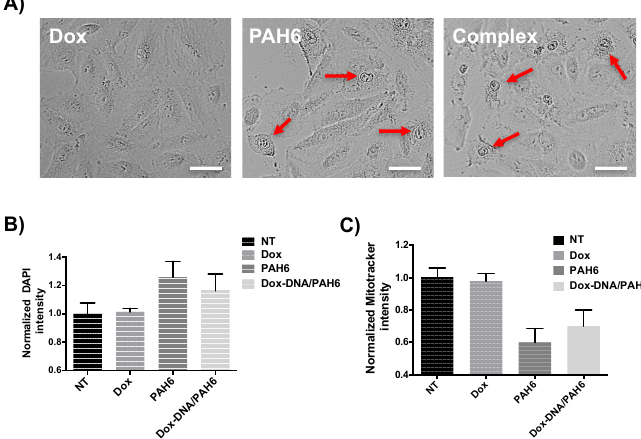
Figure 3. ( A ) Optical micrographs showing the morphologies of the A549 cells after 30 min incubation with Dox (2 µ g/mL), PAH6 (120 µ g/mL), and the Dox-DNA/PAH6 (11:60) NC at corresponding concentrations. The scale bar indicates 40 µ m. Arrows indicate the cells undergoing necrotic death. ( B ) The normalized fluorescence intensity of DAPI permeating into the cells after 30 min incubation with Dox (1 µ g/mL), PAH6 (60 µ g/mL), and the Dox-DNA/PAH6 (11:60) NC at corresponding concentrations. The DAPI fluorescence intensity of the nontreated (NT) cells is set as 1 for intensity normalization. Error bars represent SD ( n = 3). ( C ) The normalized fluorescence intensity of MitoTracker Red that binds to the mitochondrial membranes of the cells after 1 h incubation with Dox (1 µ g/mL), PAH6 (60 µ g/mL), and the Dox-DNA/PAH6 (11:60) NC at corresponding concentrations. The MitoTracker Red fluorescence intensity of the nontreated (NT) cells is set as 1 for intensity normalization. Error bars represent SD ( n =